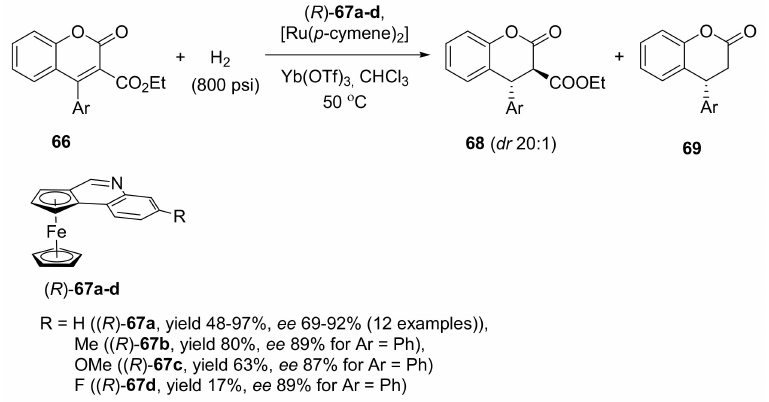
Scheme 13. Biomimetic asymmetric reduction of C=C bond.